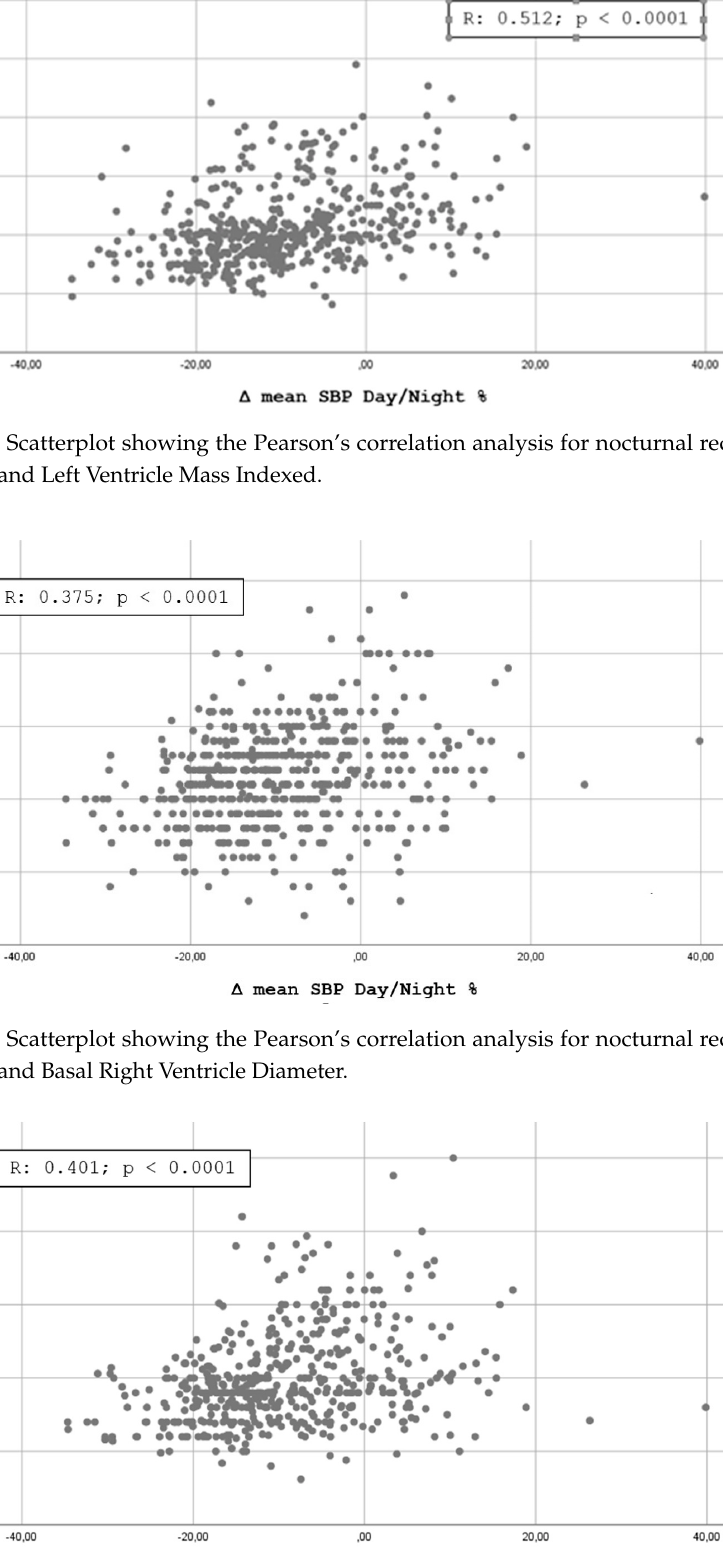
Figure 4. Scatterplot showing the Pearson’s correlation analysis for nocturnal reduction of blood pressure and Right Atrium Area.